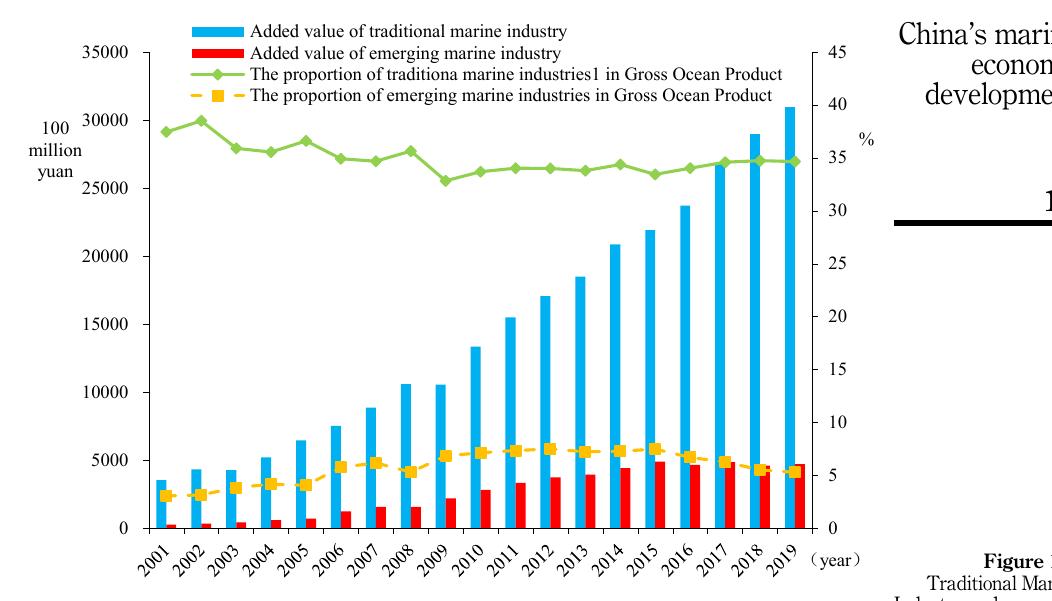
Figure 12. Traditional